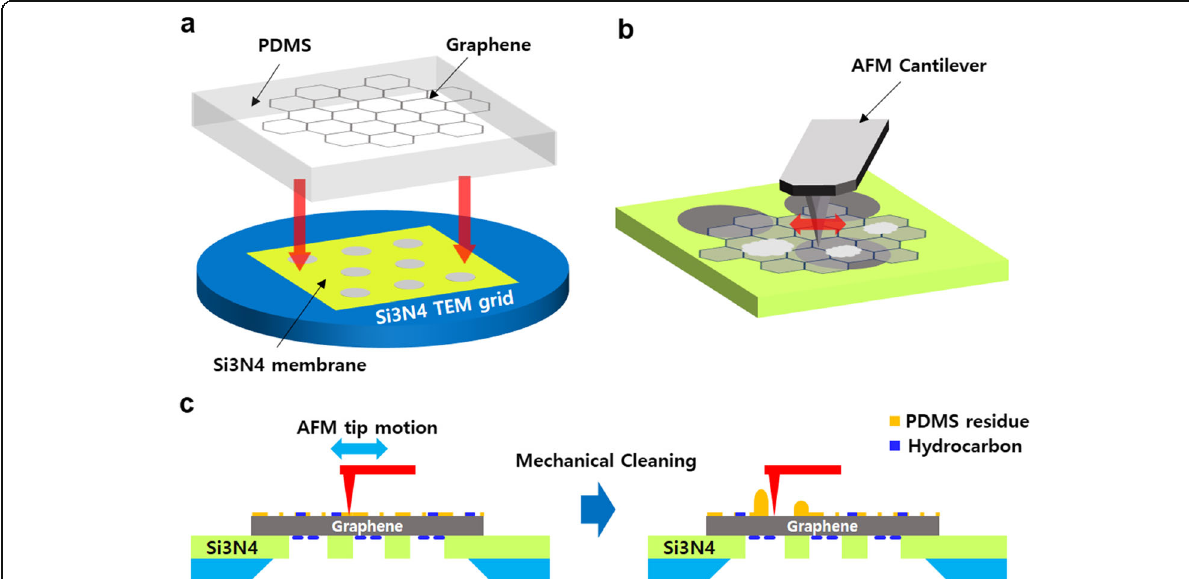
Fig. 1 Schematics of the AFM-based mechanical cleaning process of a TEM sample. a Schematic illustration of the sample fabrication of graphene on a Si